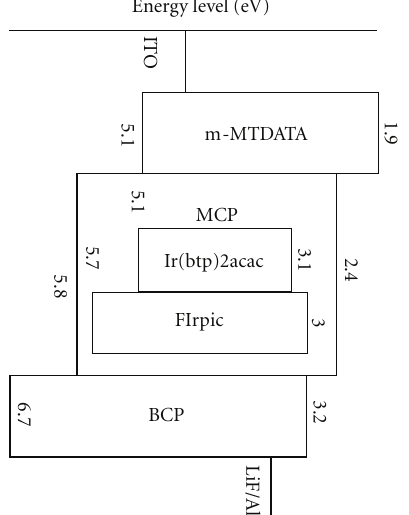
Figure 1: Energy diagram in all RGB-type samples. Figure 2: Energy diagram in all RB-type samples.